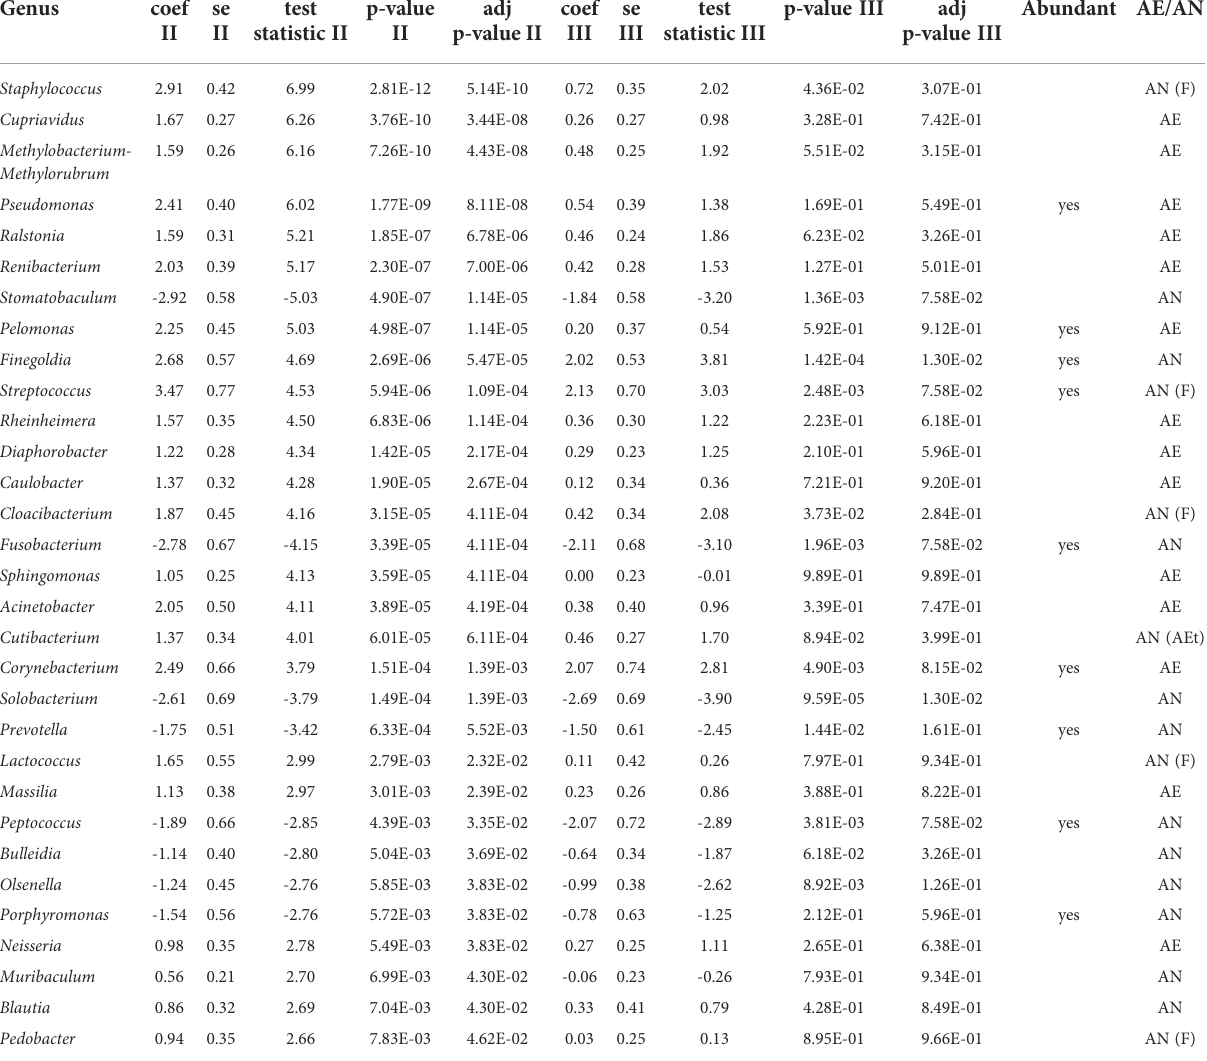
TABLE 3 Bacteria on genus level differentiating pretreatment samples and posttreatment samples (after treatment and 3-month post-treatment).